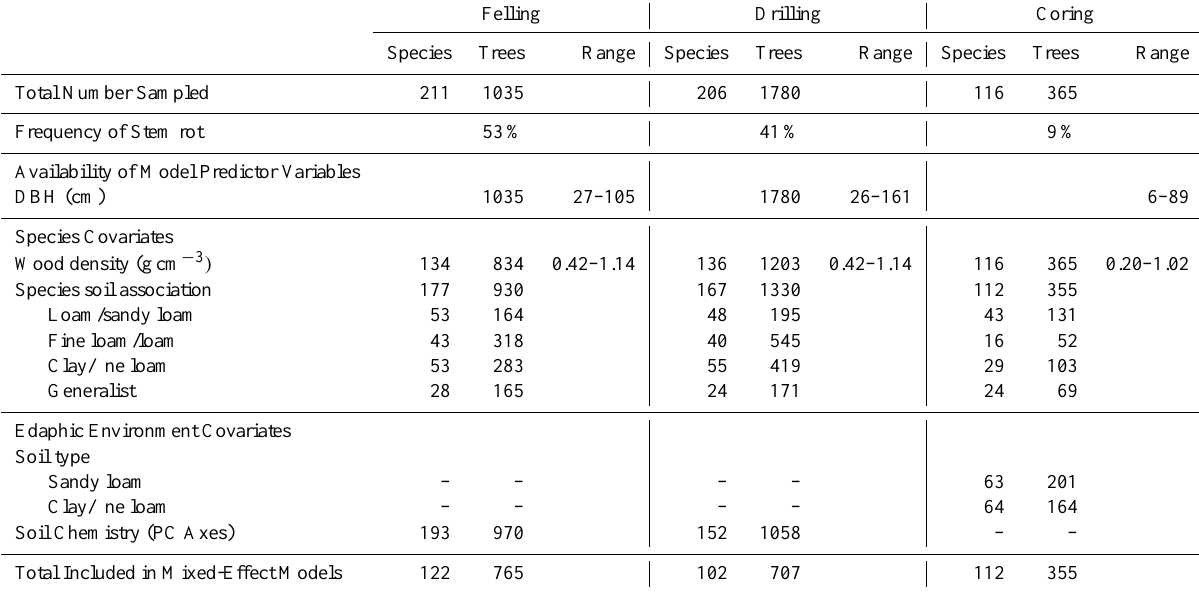
Table 1. Total number of trees and species (including morphospecies) evaluated for the presence of stem rot, and the ranges and sample sizes for predictor variables used in mixed-effect models evaluating the association of ecological covariates with frequency and severity of stem rot in the felling, drilling, and coring data sets. See Sect. 2 for